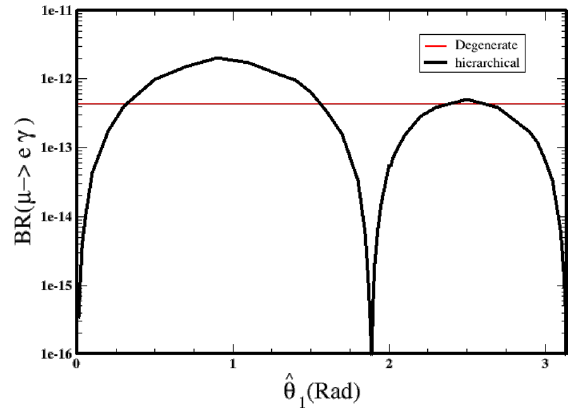
Figure 1 . BR( (cid:22) ! e(cid:13) ) vs ^ (cid:18) 1 under two di(cid:11)erent assumptions for the right-handed neutrinos using the CMSSM with m 0 = 650 GeV, m = 700 GeV, A 0 = (cid:0) 1400 GeV and tan (cid:12) = 40, (cid:22) > 0 and 1 = 2 M 3 = 2 : 5 (cid:1) 10 12